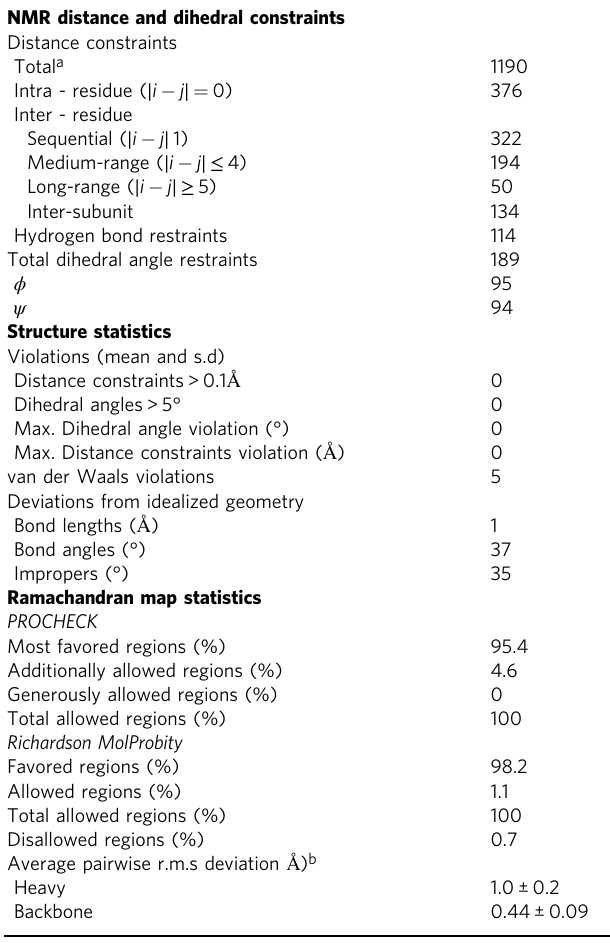
Table 1 NMR restraints and structural statistics for nMazE6. NMR distance and dihedral constraints Distance